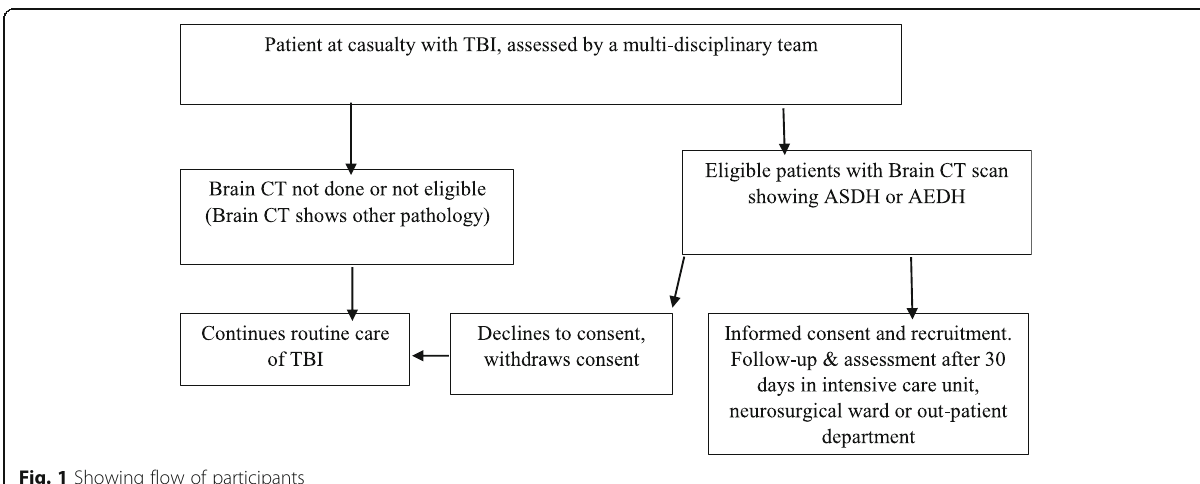
Fig. 1 Showing flow of